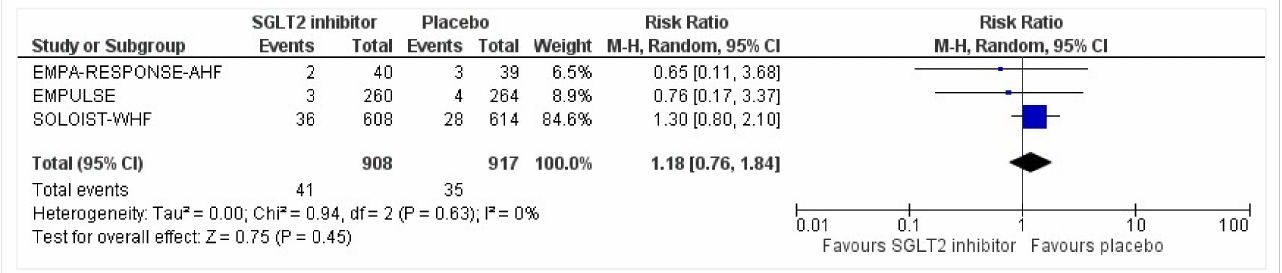
Figure 9. Forest plot for the total number of patients who had a hepatic injury as a serious adverse event during the duration of treatment in either group [25,26].